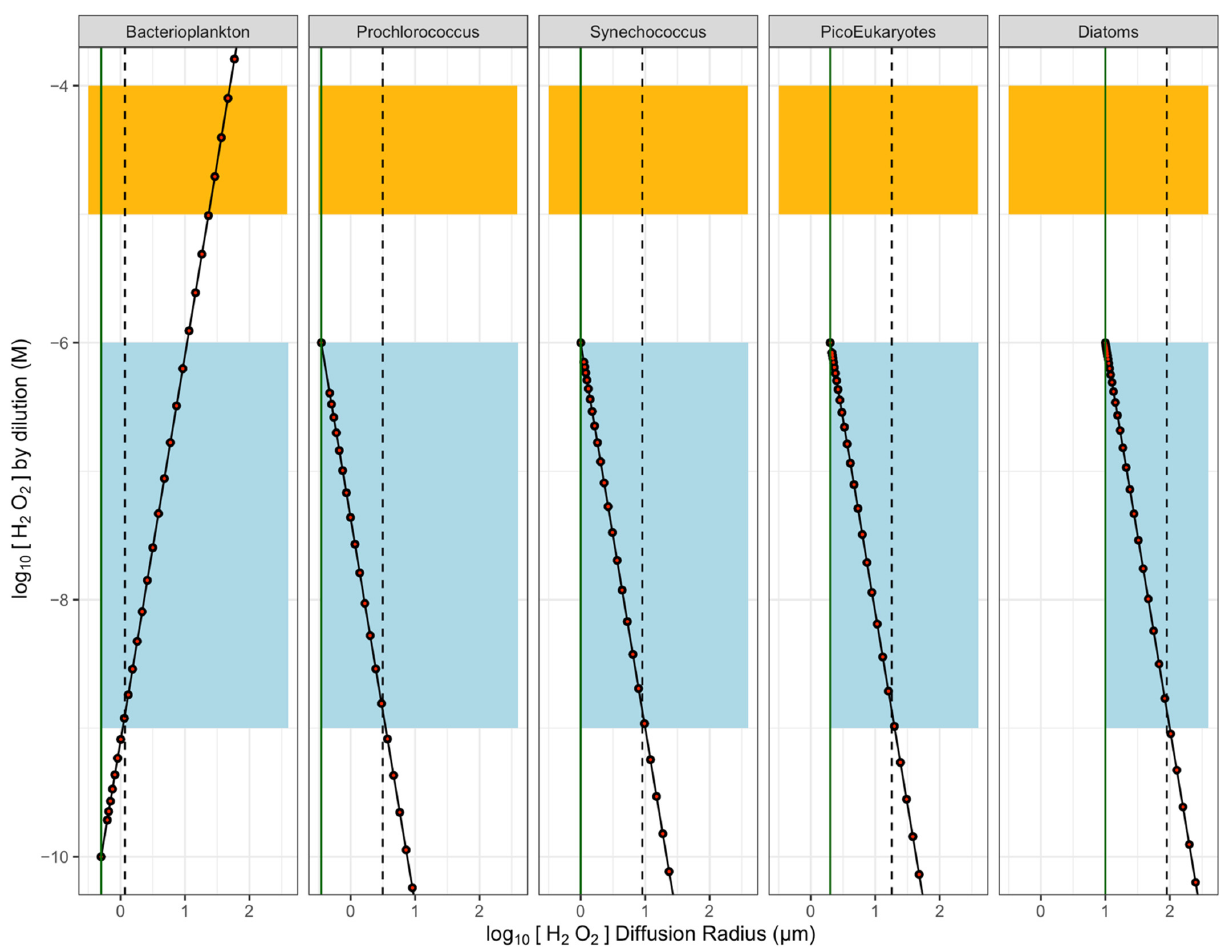
Figure 2. Estimates of concentration gradients of [H 2 O 2 ] vs. distance outwards from ‘heterotrophic’ Bacterioplankton cell maintaining an internal [H 2 O 2 ] below seawater background [H 2 O 2 ] (blue band); or outwards from ‘Phytoplankton’ cells of different radii, maintaining an internal [H 2 O 2 ] equal to 1/10 the cytotoxic threshold for [H 2 O 2 ]. Orange indicates cytotoxic concentration range for [H 2 O 2 ] (1 × 10 − 5 to 1 × 10 − 4 M). Black points show modelled [H 2 O 2 ] under the influence of dilution alone. Red points show modelled [H 2 O 2 ] under superimposed influences of dilution and (negligible) decay of H 2 O 2 . Vertical green lines indicate the cell surface. Vertical dashed lines indicate threshold radii out from cells, where [H 2 O 2 ] around the cell falls or rises to seawater background levels. Be ‐ yond that threshold, the cell has no specific, local influence upon seawater [H 2 O 2 ]. In this simple estimate, a heterotrophic bacterioplankton cell maintaining intracellu ‐ lar [H 2 O 2 ] at 1/10 of the external seawater [H 2 O 2 ] locally drops [H 2 O 2 ] below the lower end of the seawater [H 2 O 2 ] for a radius of only 1.2 μ m. If the bacterioplankton cell were to maintain an intracellular [H 2 O 2 ] of <1/10 of the external seawater [H 2 O 2 ], the threshold distances would be greater. The phytoplankton cells maintaining intracellular [H 2 O 2 ] at 1 μ mol L − 1 influence local [H 2 O 2 ] above a low background level of seawater [H 2 O 2 ] for radii of 3.1 μ m for Prochlorococcus up to 90 μ m for diatoms, or even more for yet larger phyto ‐ plankters not simulated. Furthermore, these threshold distances apply to the lowest pub ‐ lished estimates for seawater [H 2 O 2 ]. Under environments with higher seawater [H 2 O 2 ], the threshold distances would be smaller.